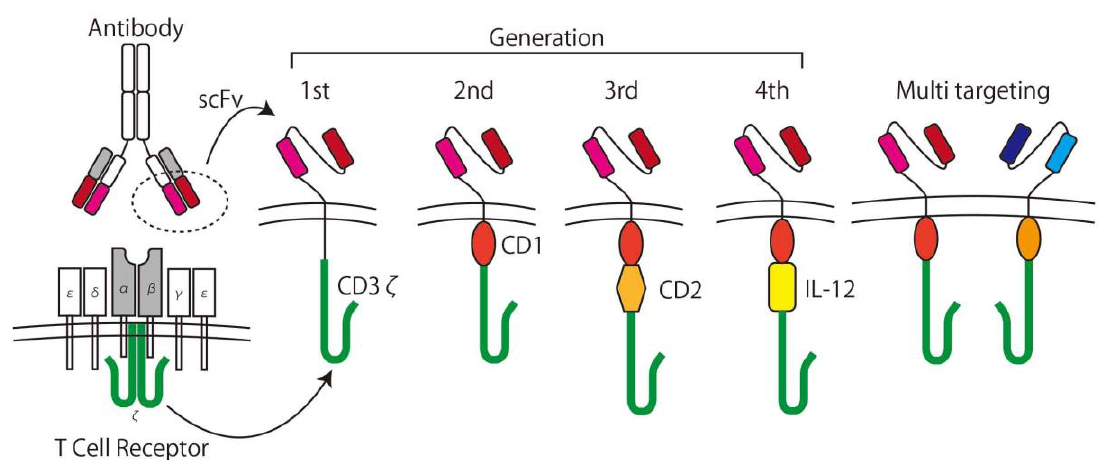
Figure 3. The development of chimeric antigen receptor (CAR) T-cells. A CAR consists of a single chain variable fragment (scFv) as the antigen recognition domain and CD3 ζ as the T-cell signaling domain. Later generation CARs have at least one co-stimulating domain (e.g., CD27, CD28, CD134, CD137) and cytokine inducible domains (e.g., IL-12). Multi-targeting CARs have two or more sets of CARs on the surface of the T-cell.